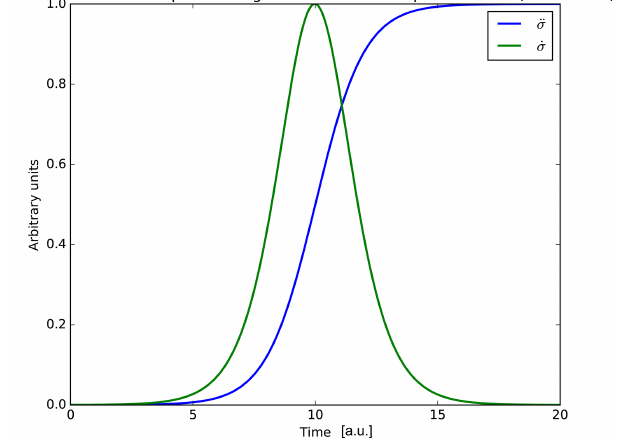
Figure 2. Dimensionless representation of normalized first and sec- ond temporal change in the uniaxial stress used by Venegas-Aravena et al. (2019). According to De Santis et al. (2019a) the earthquakes occur close to the center of figures. Here it is when t = t 0 =